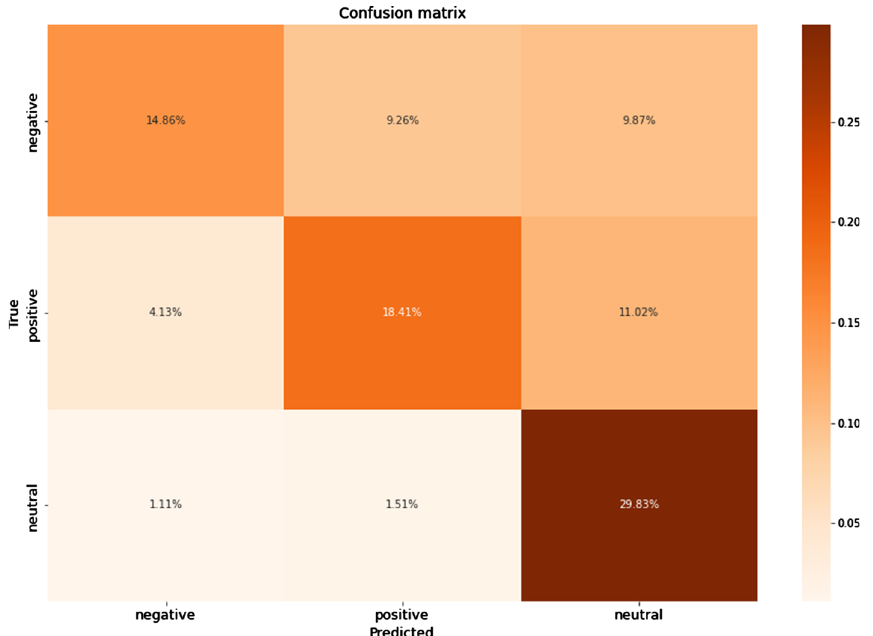
Fig. 20 A confusion matrix for Russian texts of a DT